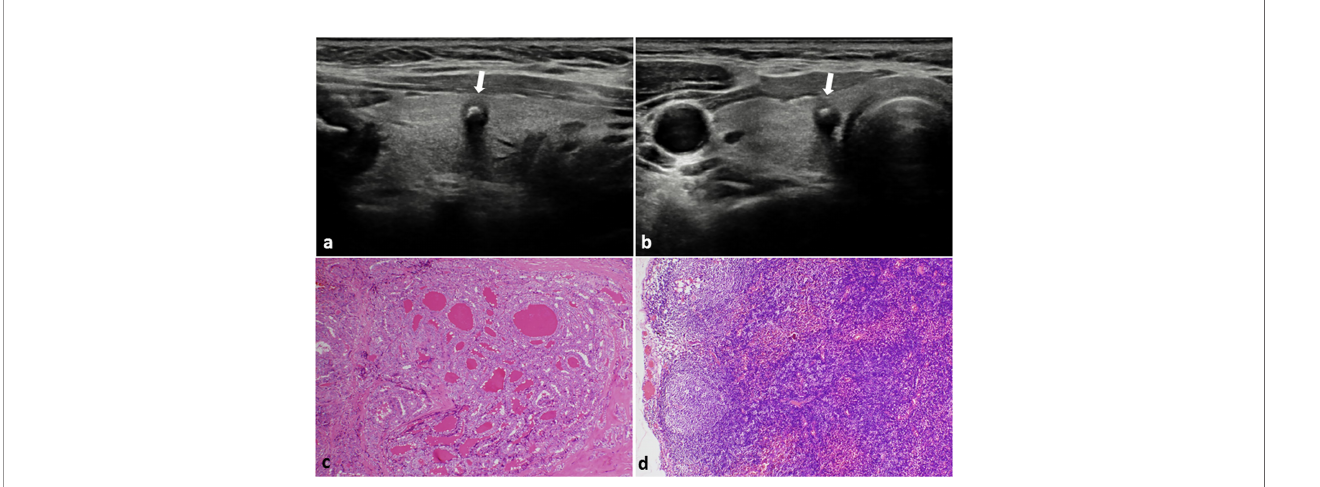
FIGURE 1 | PTC with negative CLNM in a 48-year-old female. (A) Longitudinal sonogram and (B) Transverse sonogram showing a 5×5×6 mm hypoechoic nodule in the right lobe of thyroid (arrow). The nodule was regular, legible, with a taller than wide shape and absence of extracapsular invasion. A bulky calci fi cation (> 1 mm) was observed inside the nodule. Histological examination of the tumor (C) and lymph nodes (D) indicated no lymph nodes metastasis in the central area of the neck. H-E ×